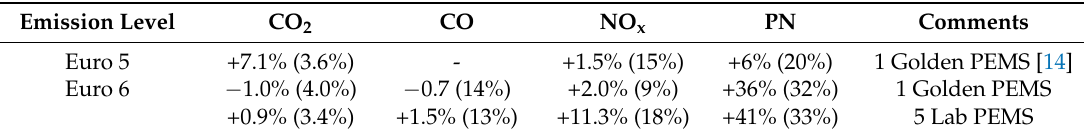
Table 4. Mean differences of PEMS from bags from inter-laboratory exercises with gasoline vehicles. In brackets the relative standard error (Coefficient of Variation), i.e., the standard deviation of the differences divided to the mean